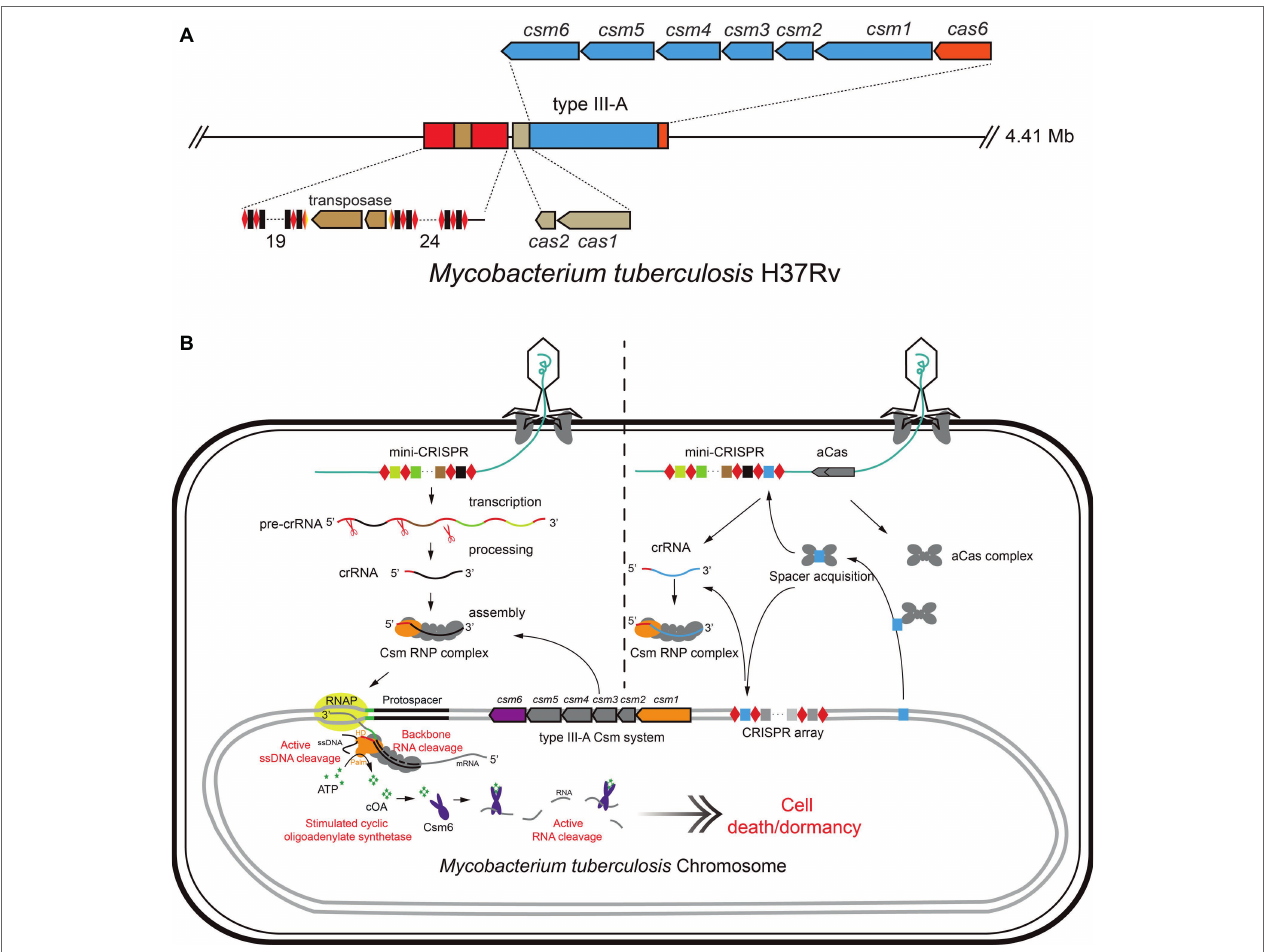
FIGURE 2 | Schematic of endogenous CRISPR-Cas system-based method for elimination of M. tuberculosis . (A) The CRISPR locus of M. tuberculosis includes two CRISPR loci and cas genes encoding Cas1/Cas2 (Adaptation module), Csm1-5 (type III-A interference module), Csm6 (ancillary ribonuclease), and Cas6 (crRNA processing). (B) The mini-CRISPR against the essential DNA of M. tuberculosis was delivered by mycobacteriophage. After transduction, mini-CRISPR was replicated with phage DNA and transcribed. The CRISPR RNA was processed by the endogenous Cas nuclease (eg. Cas6). Then, the endogenous Csm complex binds mature crRNA to form Csm RNP complex (model on the left). Alternatively, expression of CRISPR-Cas adaptation proteins leads to spacer acquisition from the chromosome, facilitating the self-targeting activity of endogenous CRISPR-Cas systems in the cell (model on the right). Csm RNP recognizes and cleaves the target RNA, inducing cleavage of non-specific single-strand DNA in cells. This process will induce synthesis of cOAs by the Cas10 subunit of Csm RNP complex. cOAs activate the non-specific ribonuclease activity of Csm6, resulting in cell dormancy or